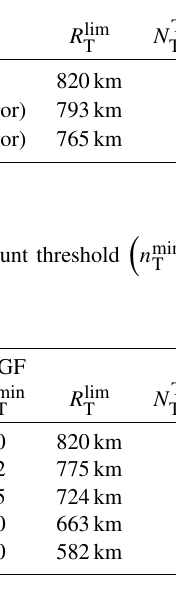
Table B1. Effect of an overestimated effective area